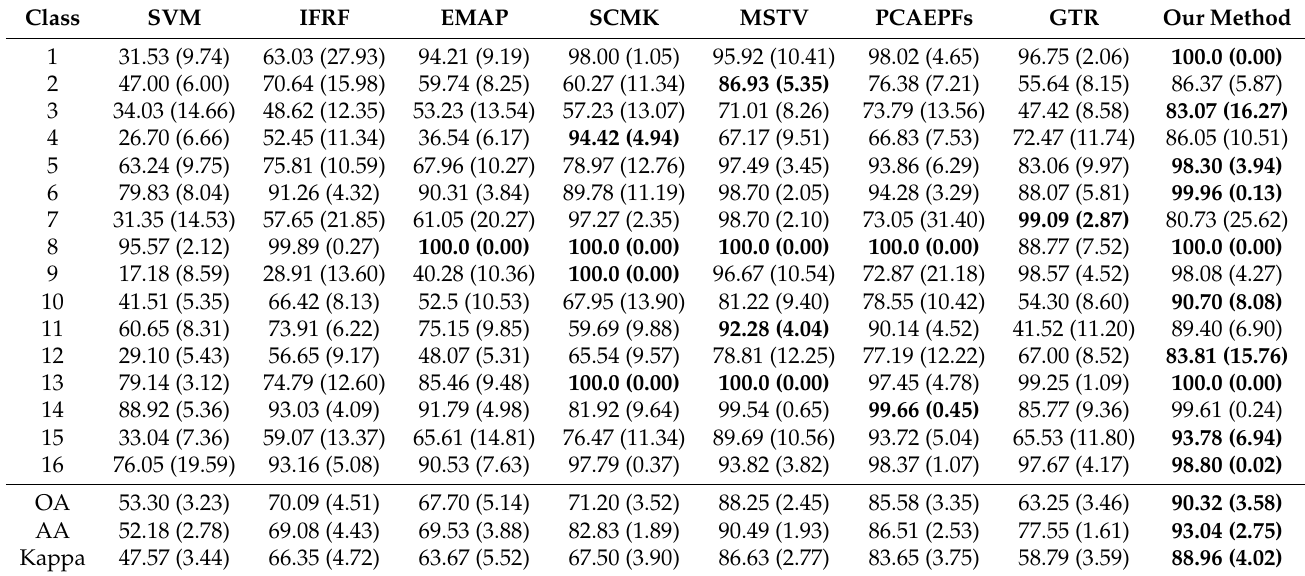
noisy labels and preserving the boundaries of different